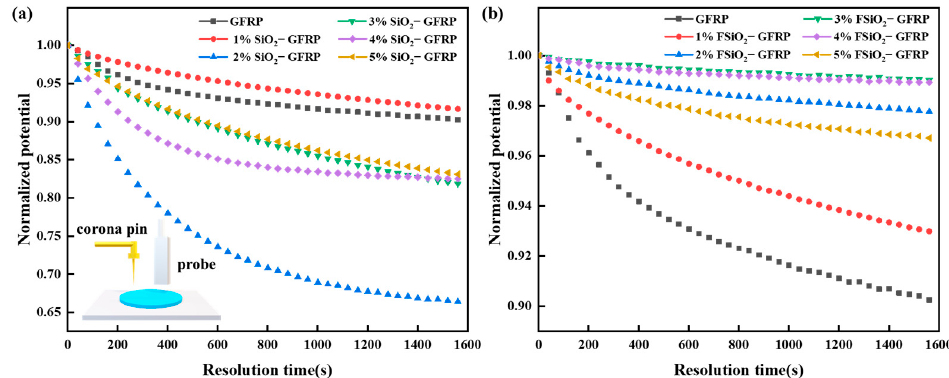
Figure 5 . Potential decay curve of GFRP samples. ( a ) SiO 2 -GFRP. ( b ) FSiO 2 -GFRP. Figure 5. Potential decay curve of GFRP samples. ( a ) SiO